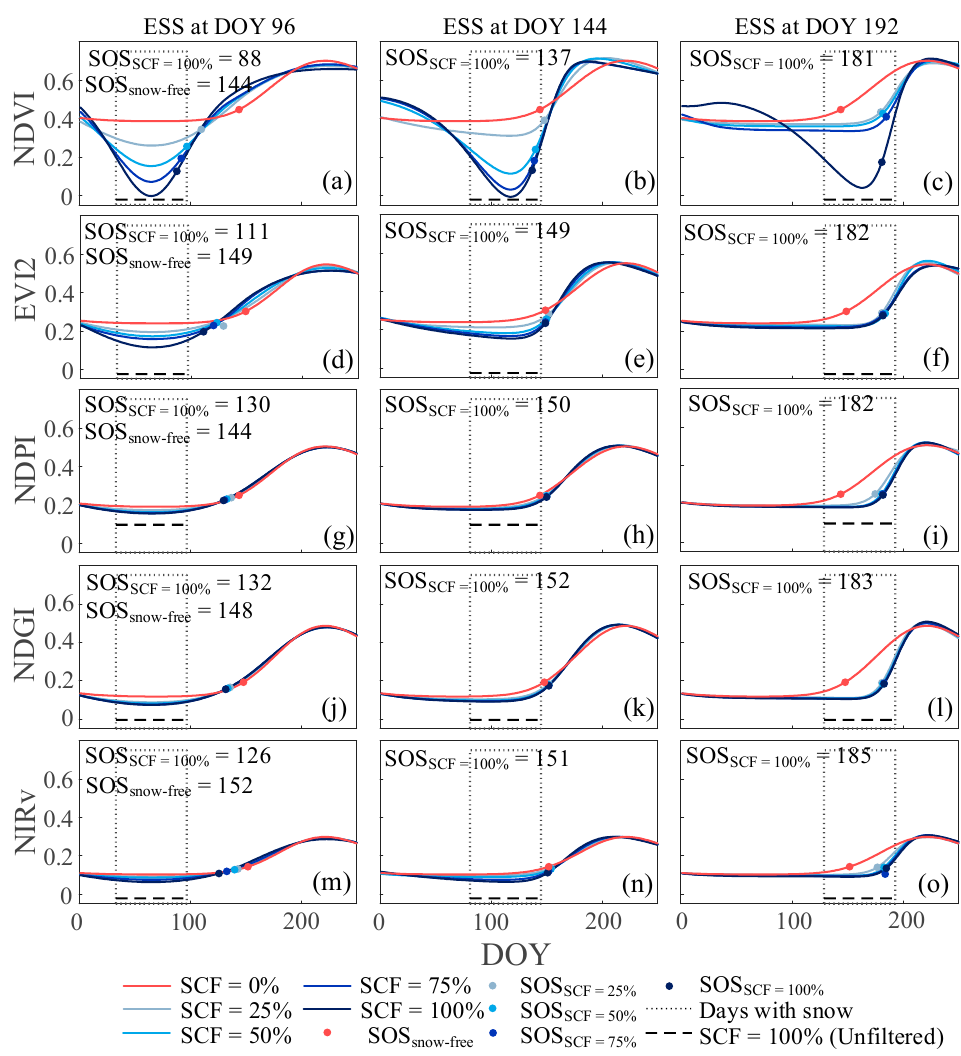
Figure 13. Time curves and the detected SOS of the five VIs under different SCF and ESS cases at SCDc = 64. ( a – c ), ( d – f ), ( g – i ), ( j – l ), and ( m – o ) are the time curves of five VIs, for each of which three ESS cases at DOY 96, 144, and 192 and five cases of SCF = 0%, 25%, 50%, 75%, and 100% were plotted.